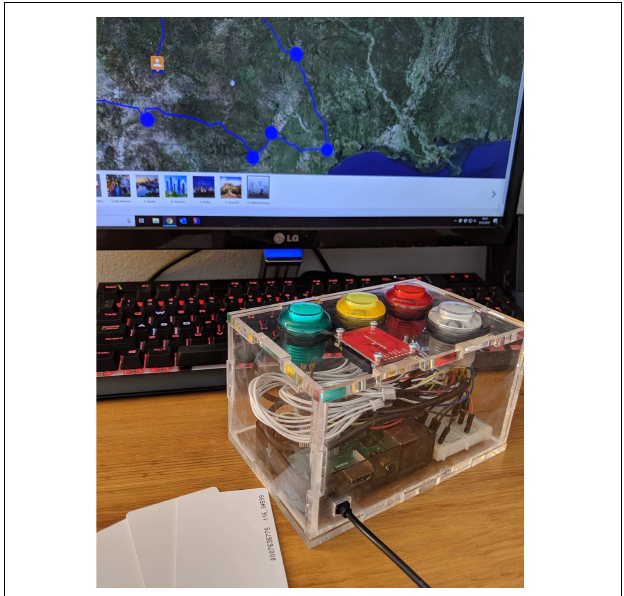
FIGURE 2 | SMART box for RFID badge and self-report of physical activity. The figure is reused from Julien et al. (2021) with